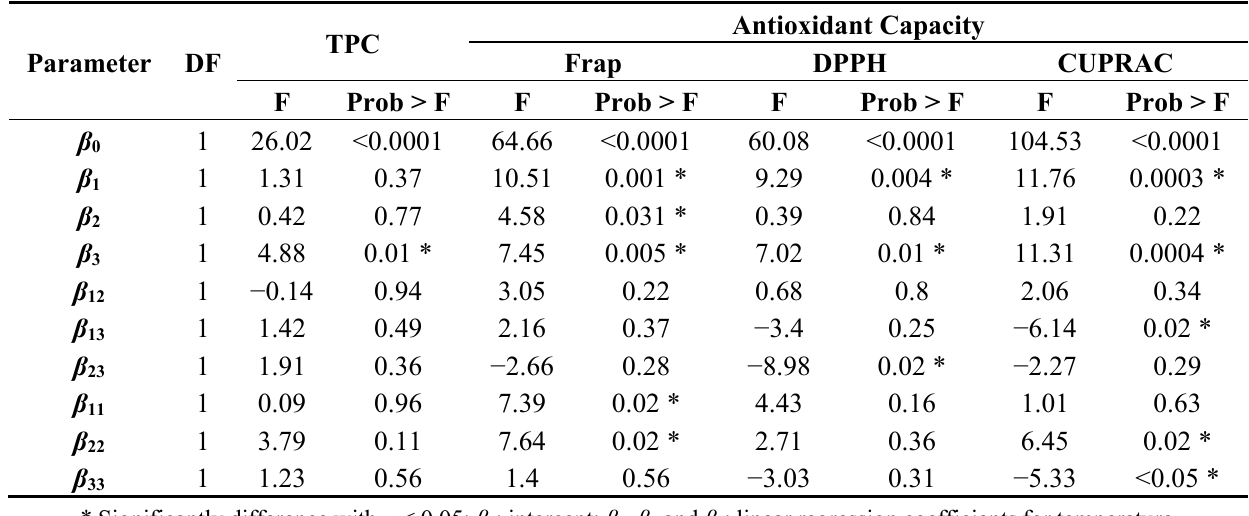
Table 3. The analysis of variance for the experimental